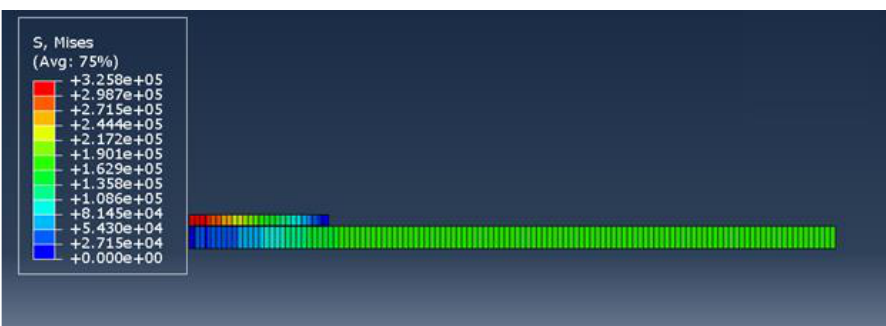
Figure 13. Meshed specimen with zero thickness of cohesive elements.